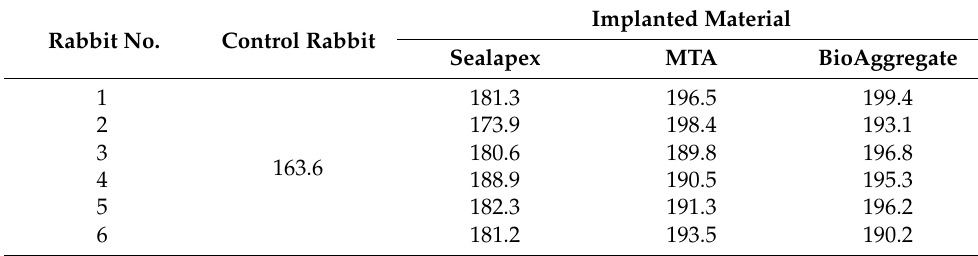
Table 2. Alkaline phosphatase values at 30 days postoperatively (IU/L). Rabbit No.